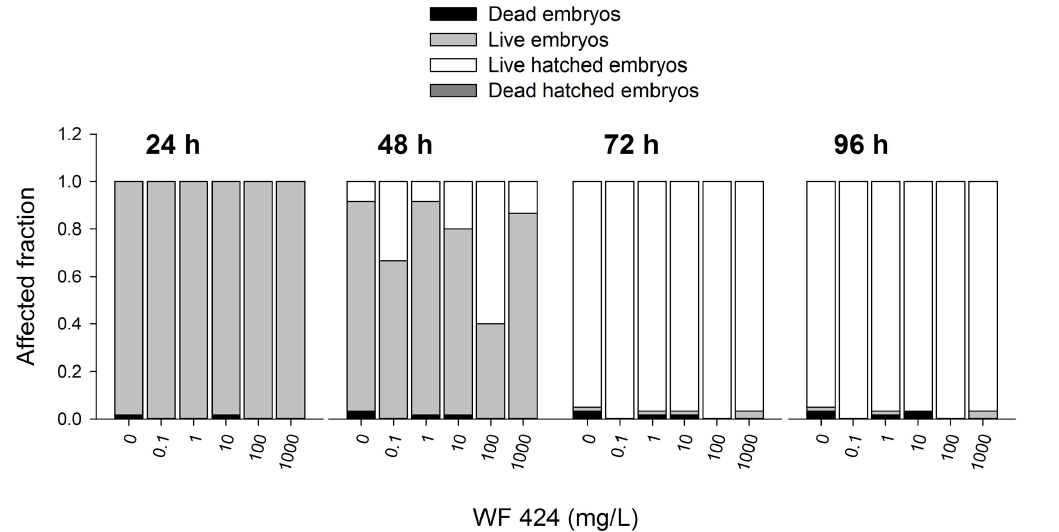
Figure 1. Overview of zebrafish embryo toxicity test after 96 h of exposure to WF424. The proportion of eggs and non-hatched embryos that died are represented by black bars; the proportion of embryos that stayed alive but did not hatch are presented as grey bars; those that hatched as white bars and the proportion of embryos that died after hatching as spotted, dark dashed grey bars.